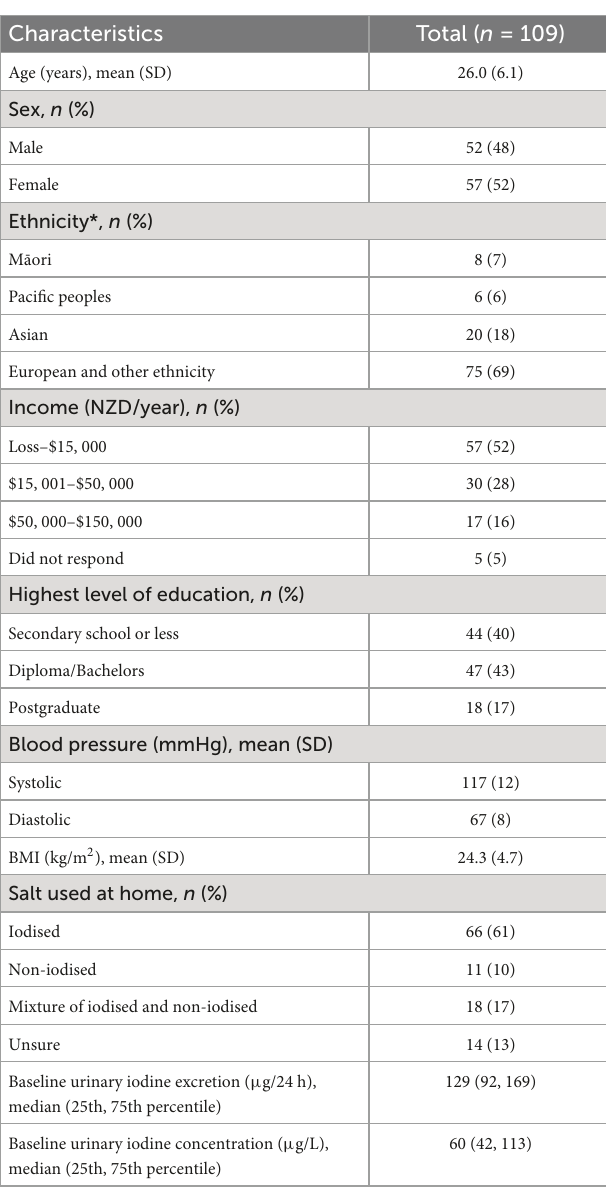
TABLE 1 Baseline characteristics of